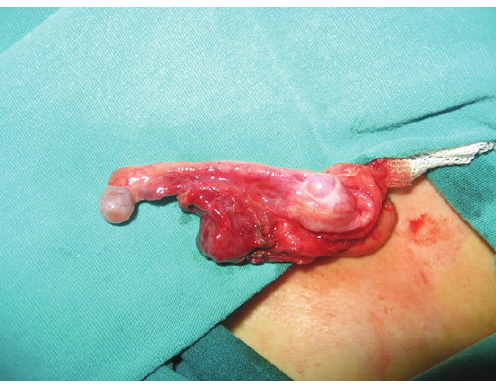
Figure 1: The small mass proximal to the left testicle proved to be a supernumerary testicle.